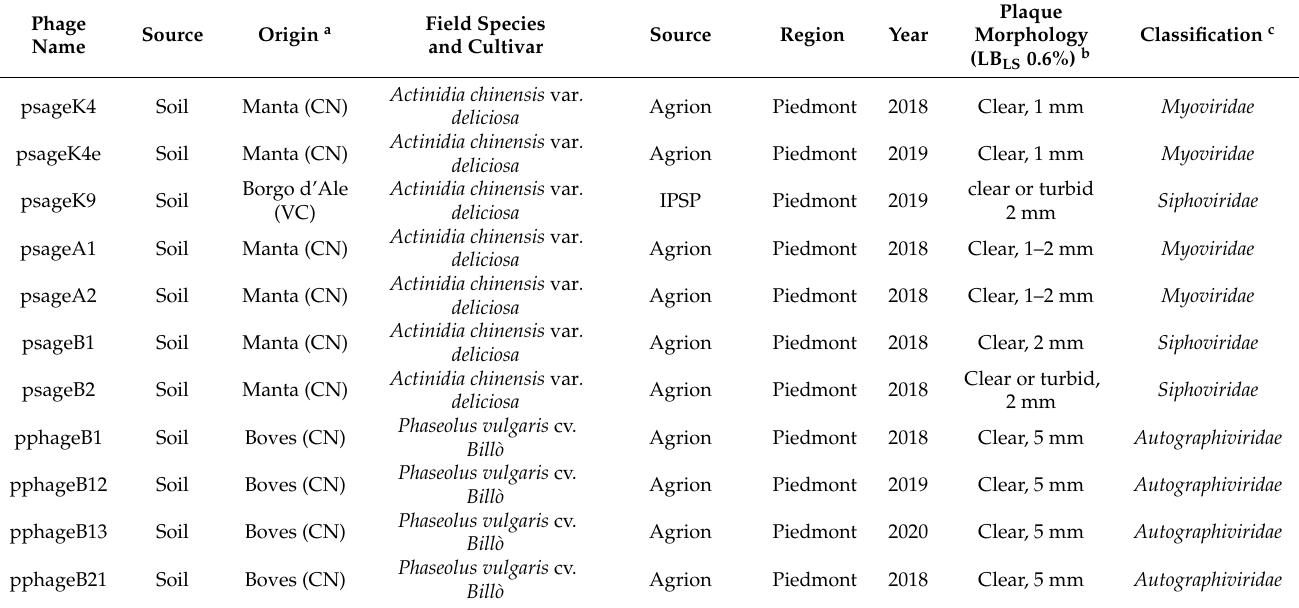
Table 2. Summary of the main features of phages isolated in this study. The classification of the phages is based on their phylogeny (Figure